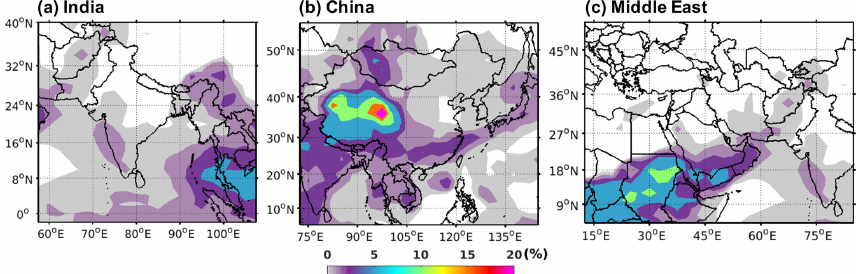
Figure 14. Percentage decrease in TFA deposition (dry and wet combined) by adding Criegee intermediate chemistry to HFO-1234yf emissions over domains in (a) India, (b) China, and (c) the Middle East